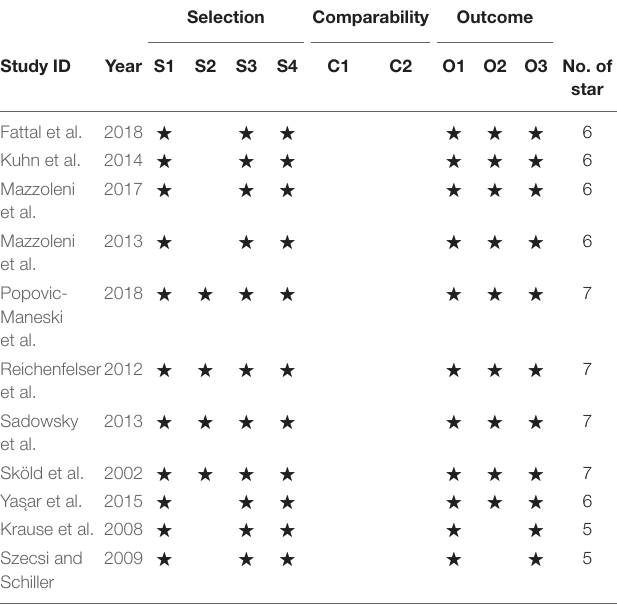
TABLE 3 | Newcastle-Ottawa Scale for assessing the quality of included non-RCT